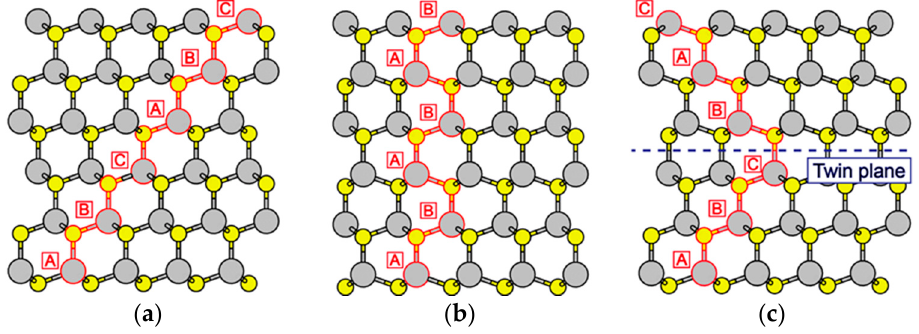
Figure 14. Schematics of crystal structures of III-V compound semiconductors. Large and small circles represent cations and anions, respectively. Stacking sequences of ( a ) zinc blende (ZB) and ( b ) wurtzite (WZ) structures are · · · ABCABC · · · and · · · ABAB · · · , respectively, while ( c ) rotational twins are formed in semiconductor nanowires (NWs). Dashed line denote a twin